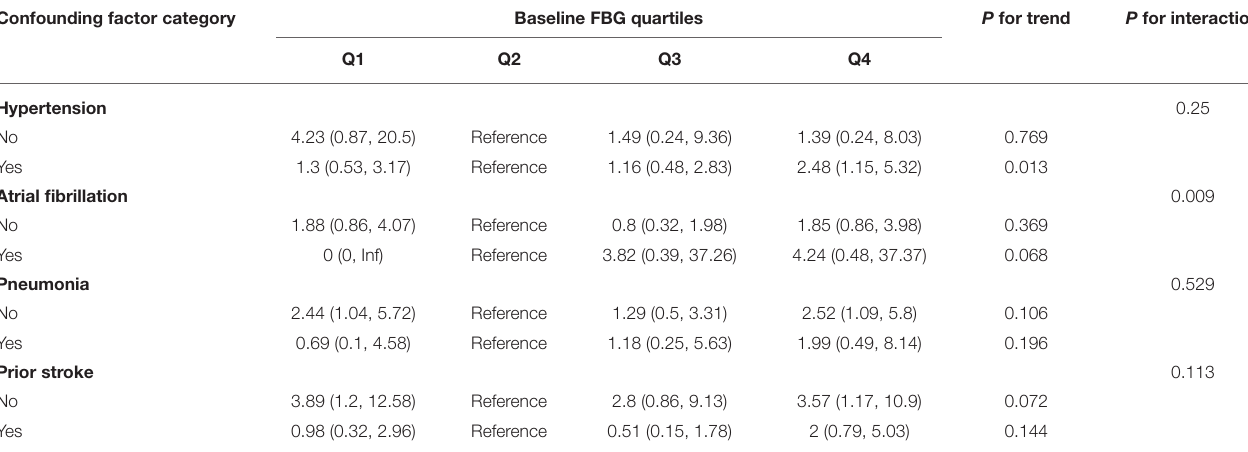
Adjusted for age, gender, smoking, drinking, prior stroke, hypertension, pneumonia, atrial fibrillation, NIHSS score at admission, blood urea nitrogen, serum creatinine. FBG, fasting blood glucose; Q1, < 4.53 mmol/L; Q2, 4.53–4.99 mmol/L; Q3, 5.00–5.59 mmol/L; Q4, > 5.59